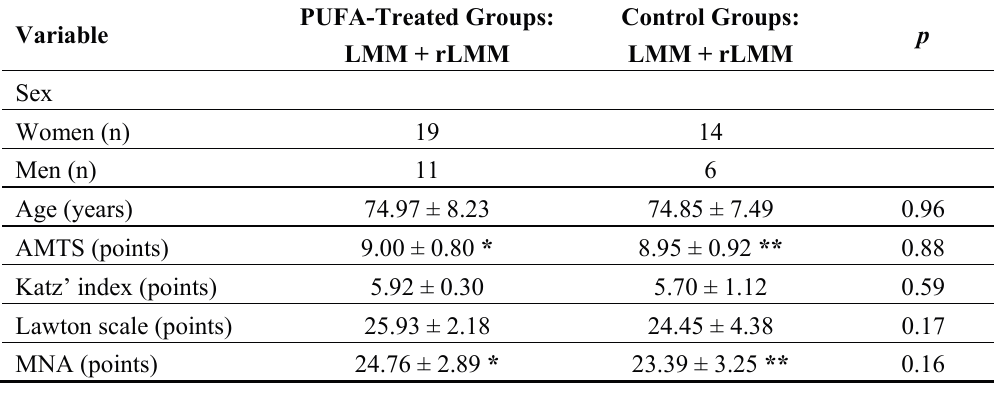
Table 1. The characteristics of studied subjects of the PUFA-treated and controls groups. PUFA-Treated Groups: Variable